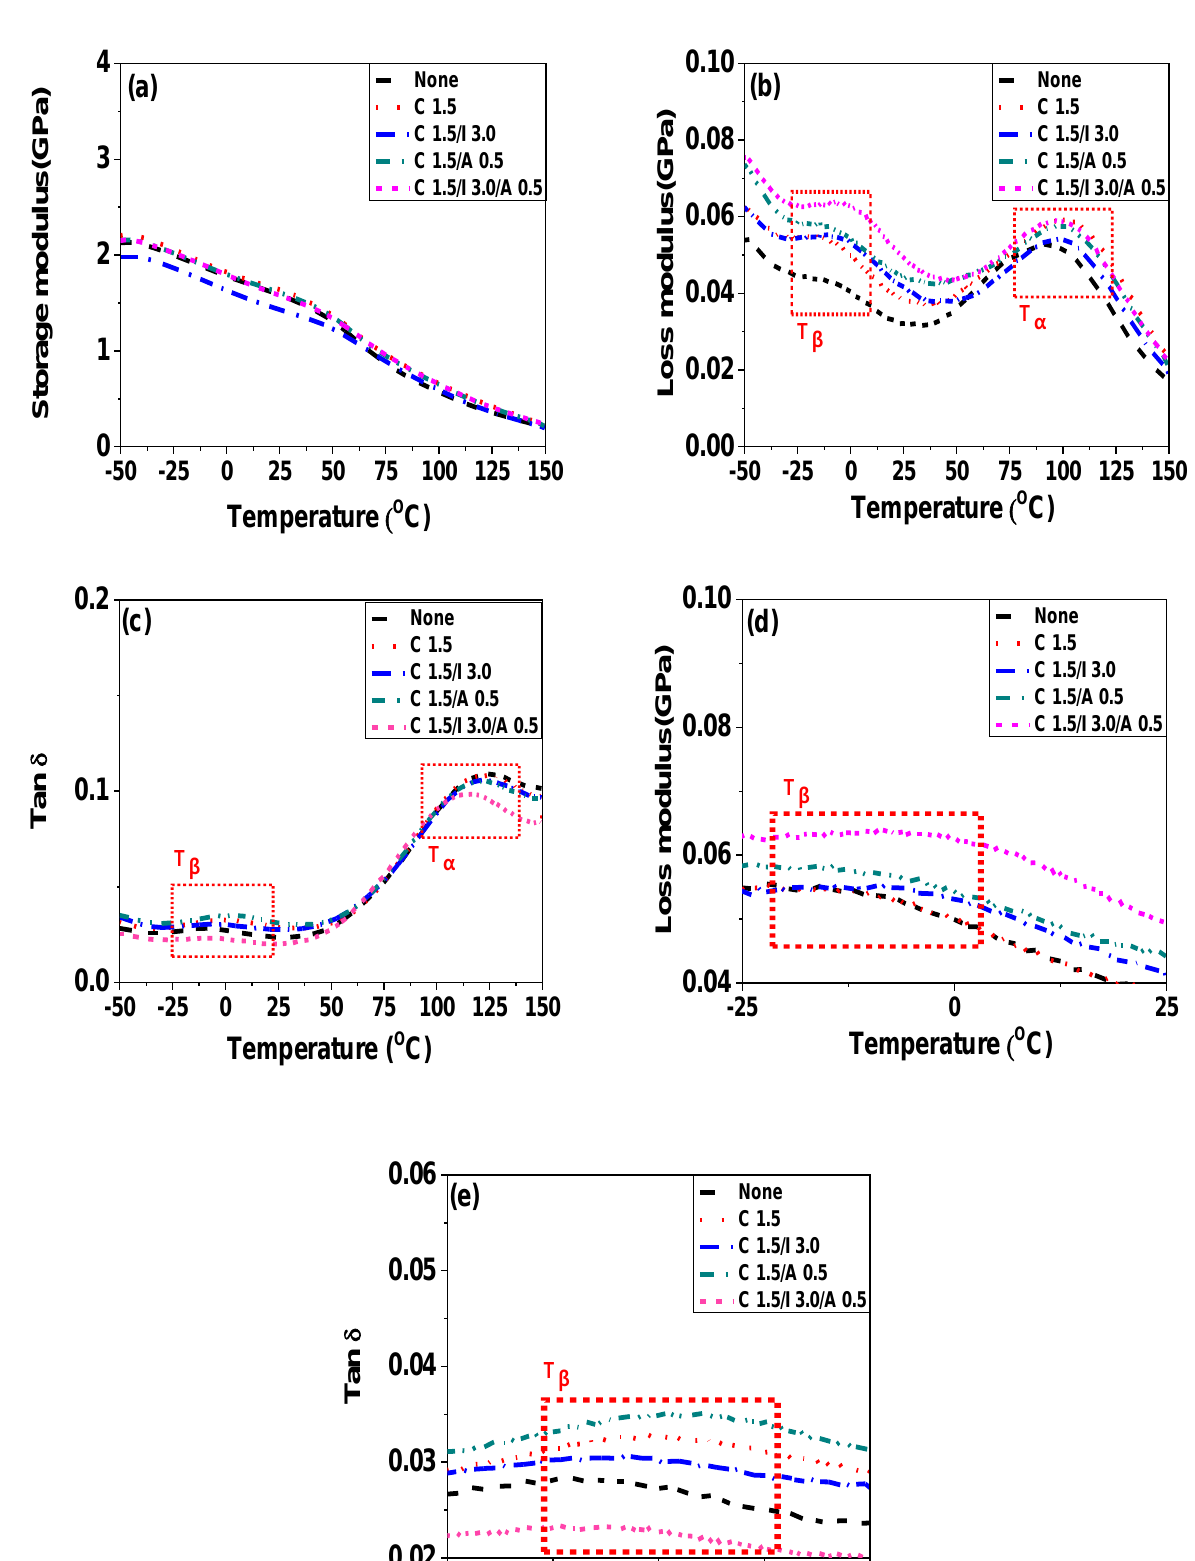
Table 5. Transition temperatures of POM/C1.5, POM/C1.5/I, and POM/C1.5/A nanocomposites with different additive concentrations, based on DMA data. Contents (wt%)